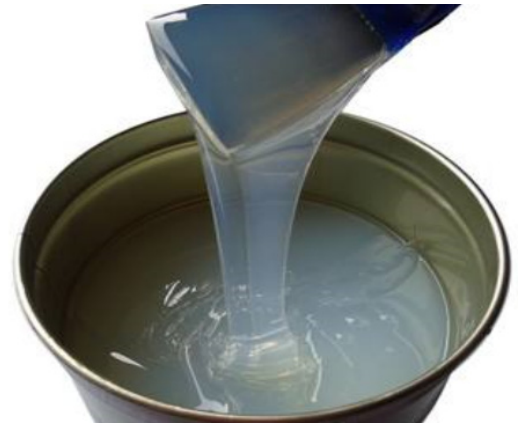
Figure 9. Liquid-like translucent silica gel.